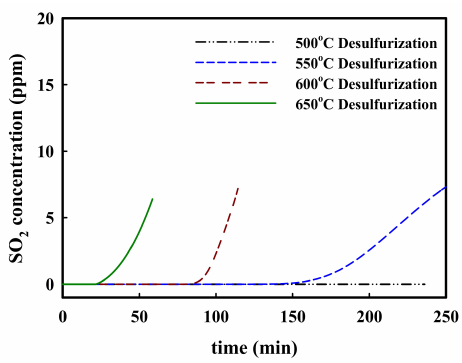
Figure 1. Effect of temperature on SO 2 generation of fresh sorbent in the desulfurization process with 4000 ppm H 2